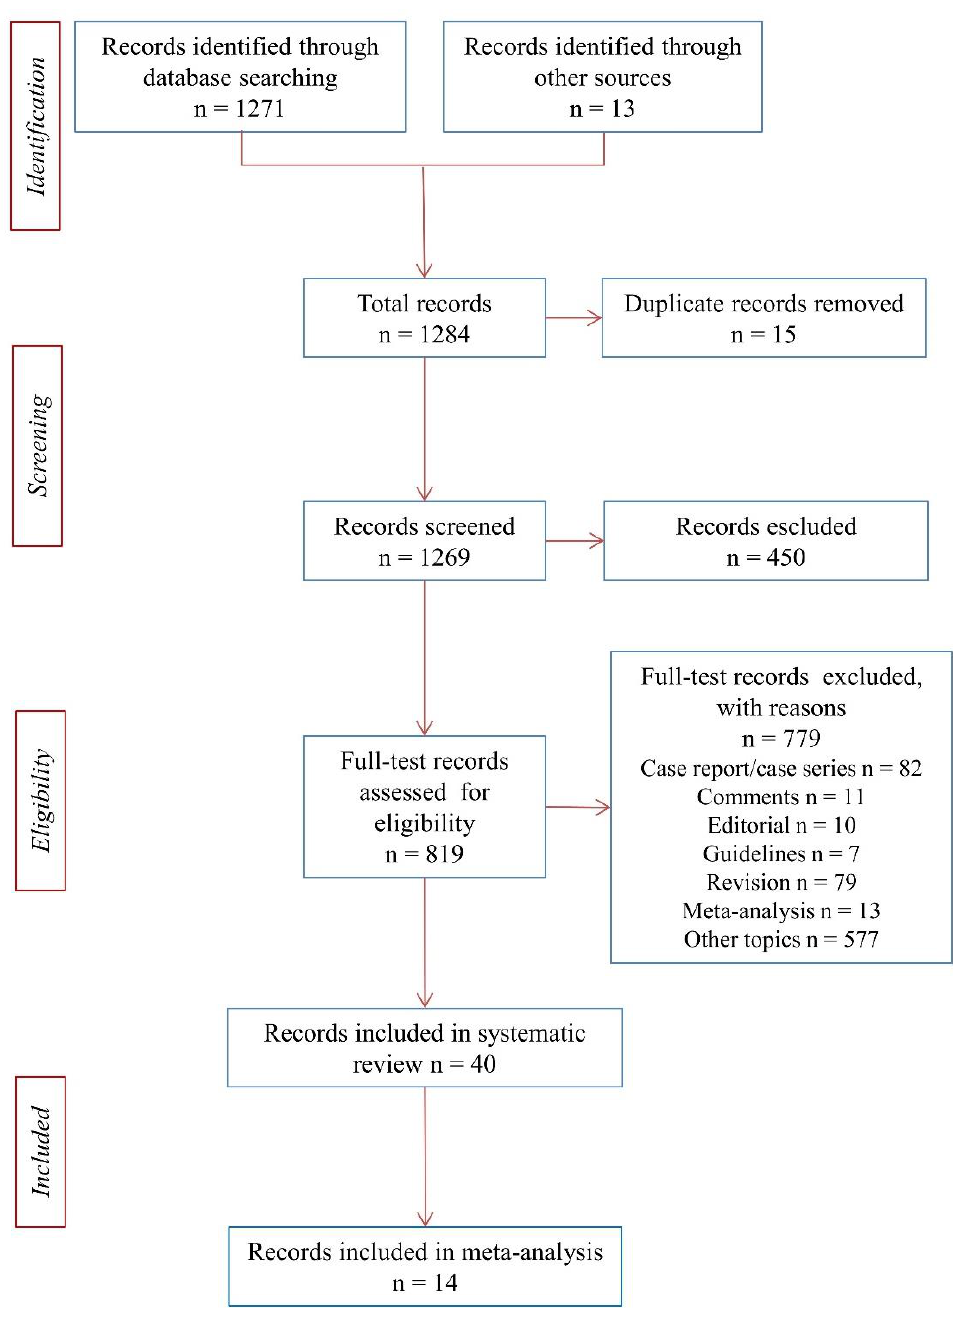
Figure 1. Flow chart of search strategy.